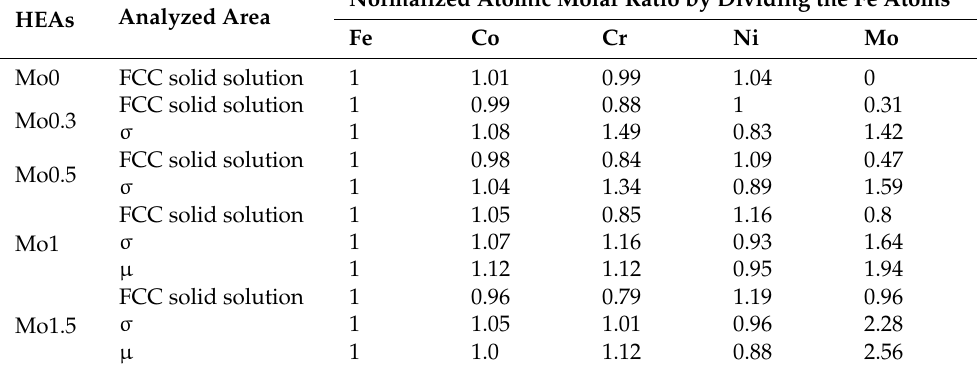
Table 2. The crystallite sizes and lattice parameters of σ / µ